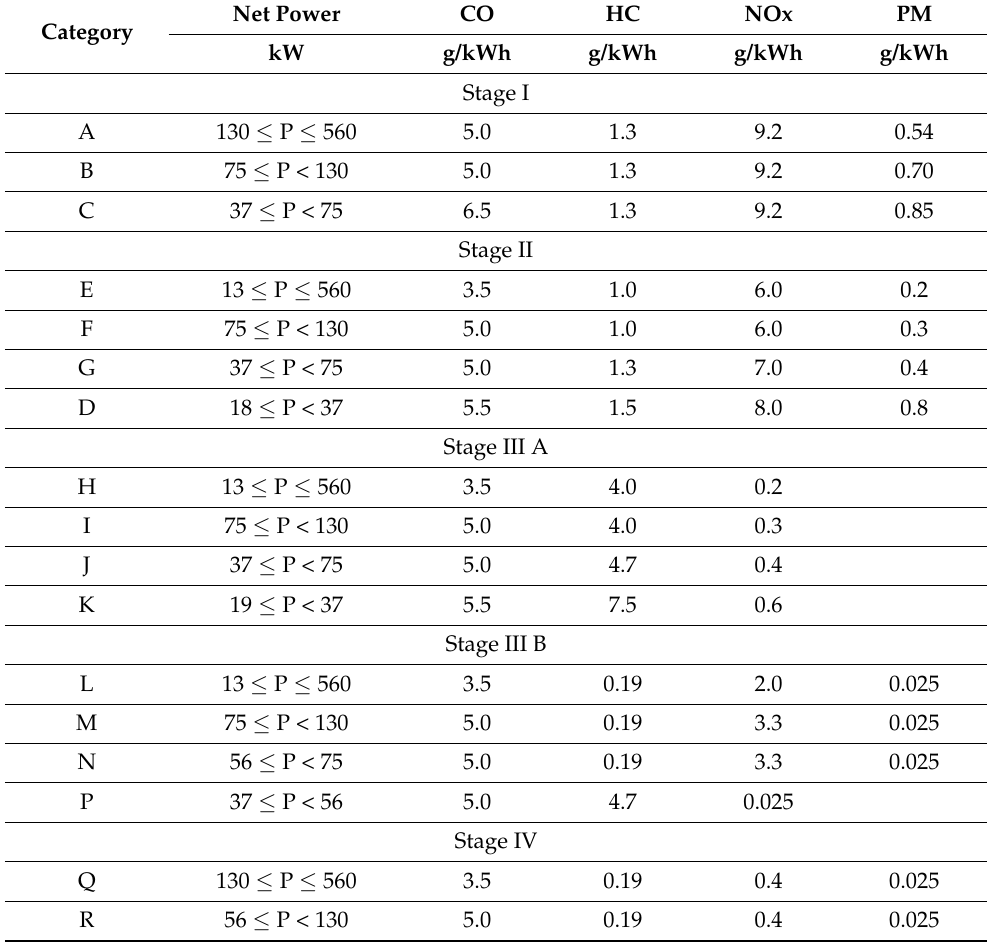
Table 1. Summary of emissions limits set by the different emissions standards in the European Union.